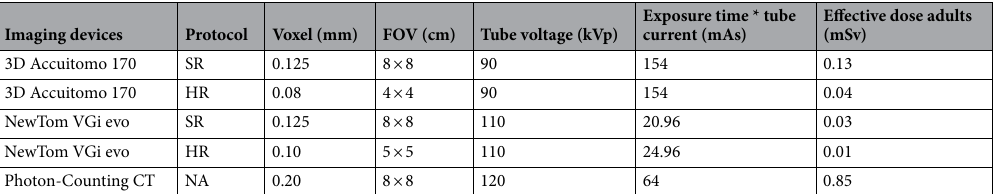
Table 1. Scanning parameters and estimated effective dose to adults of the different imaging devices. SR, standard resolution; HR, high-resolution; NA, not applicable. Dose conversion factor for adults CT head scan